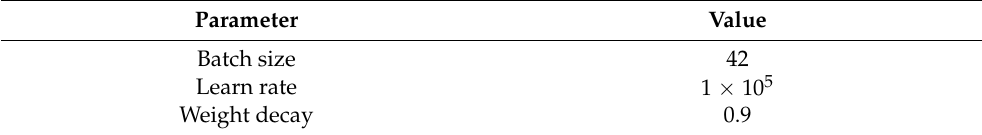
Table 6. Network hyperparameter settings.